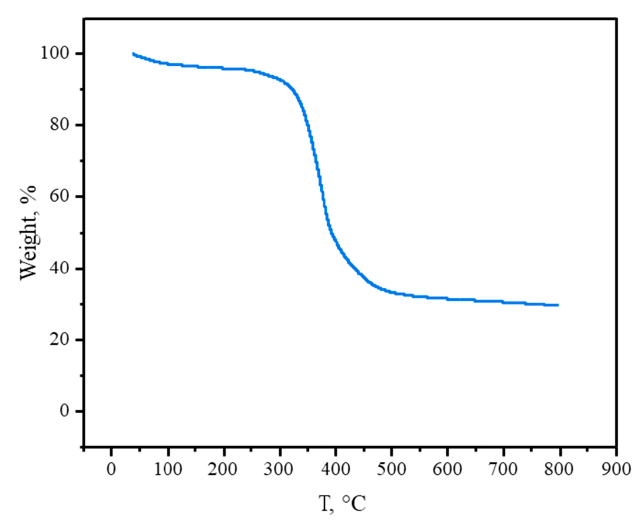
Figure A5. TGA curve of HPCP.